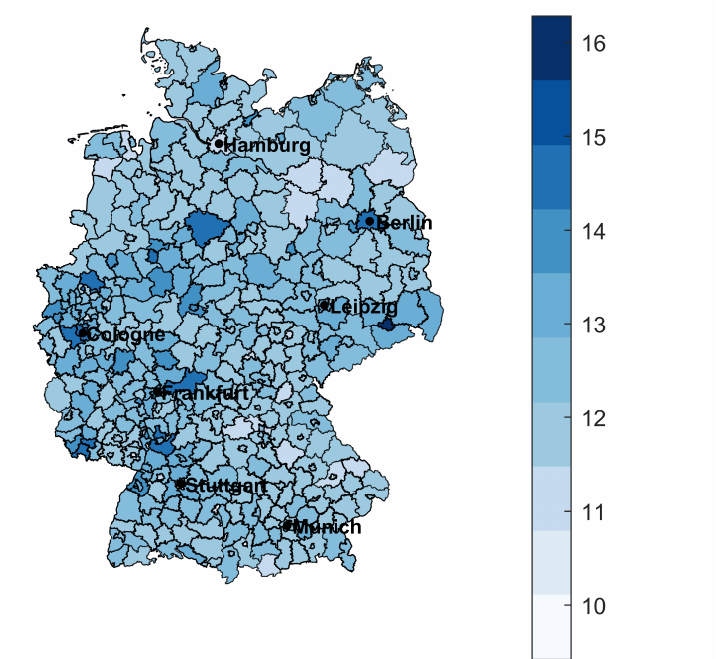
Figure 9. Attractiveness of newly built CSs by district. Dark districts are those with a high attractive- ness and light areas are those with a low attractiveness covered by the newly created